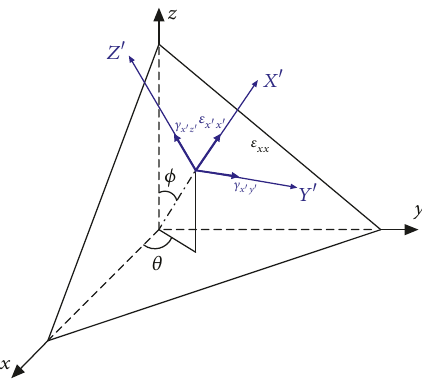
Figure 12: Normal stress distribution along the beam axial direc- tion. Figure 13: Strain acting on a plane in a three-dimensional coordi- nate